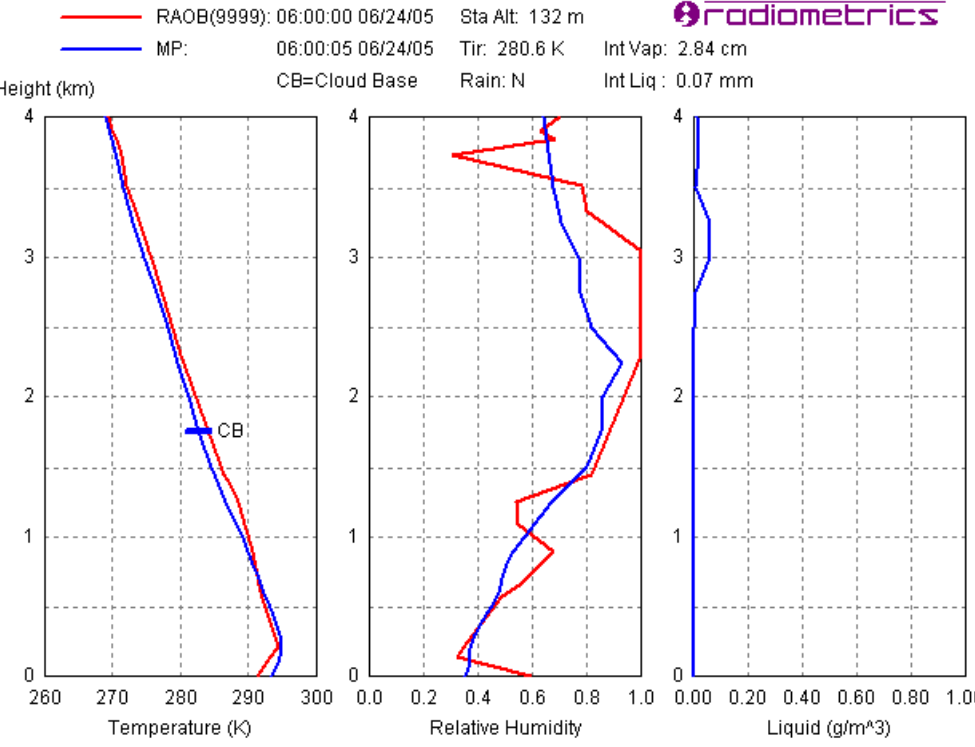
Fig. 2. Atmospheric profiles of temperature, relative humidity and liquid water measured by a radiosonde launched from Larkhill (RAOB, red line) and retrieved by microwave radiometer at Linkenholt (MP, blue line). 6 June 2005,